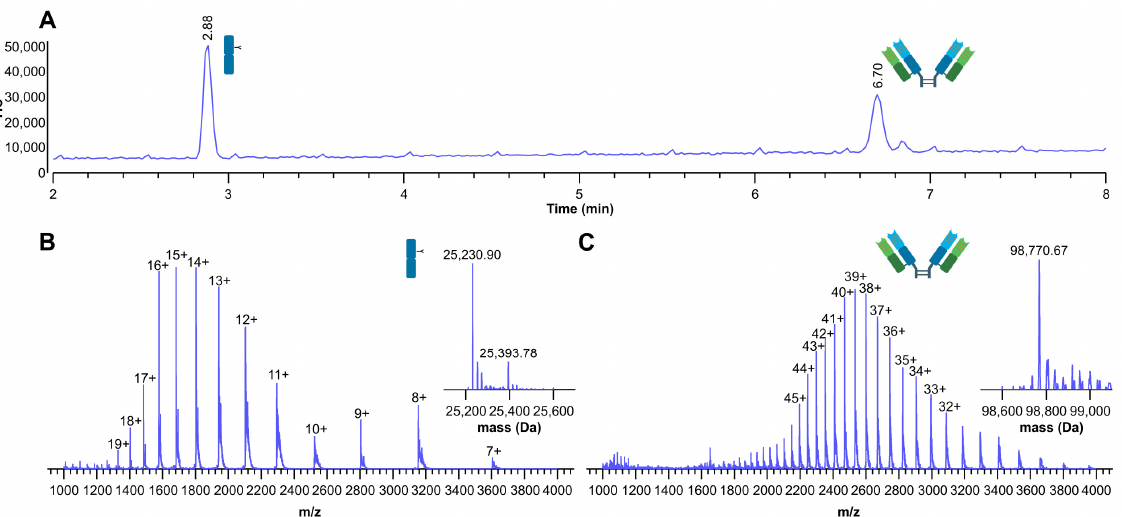
Figure 3. ( A ) Total ion chromatogram (TIC) of IdeS digested bevacizumab; ( B ) deconvoluted and multi-charged ions MS spectra with the assignments of Fc/2; ( C ) deconvoluted and multi-charged ions MS spectra with the assignment of F(ab’) 2 .